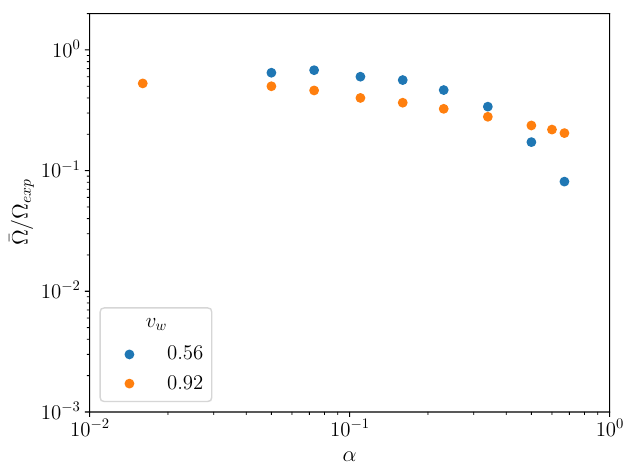
Figure 3 . Suppression factor with respect to the strength of the phase transition due to vorticity and reheating effects in the plasma. ¯Ω is the reduced peak gravitational wave energy density and Ω is the expected peak gravitational wave energy density. The data is taken from exp